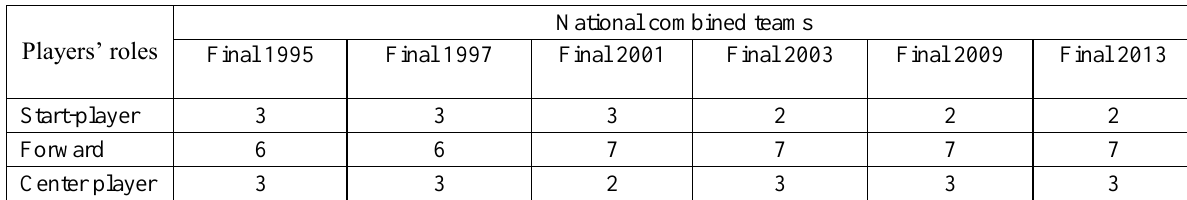
Quantitative staff of national combined basketball team of Ukraine (women) in finals of European championships 1995- 2013, n=6